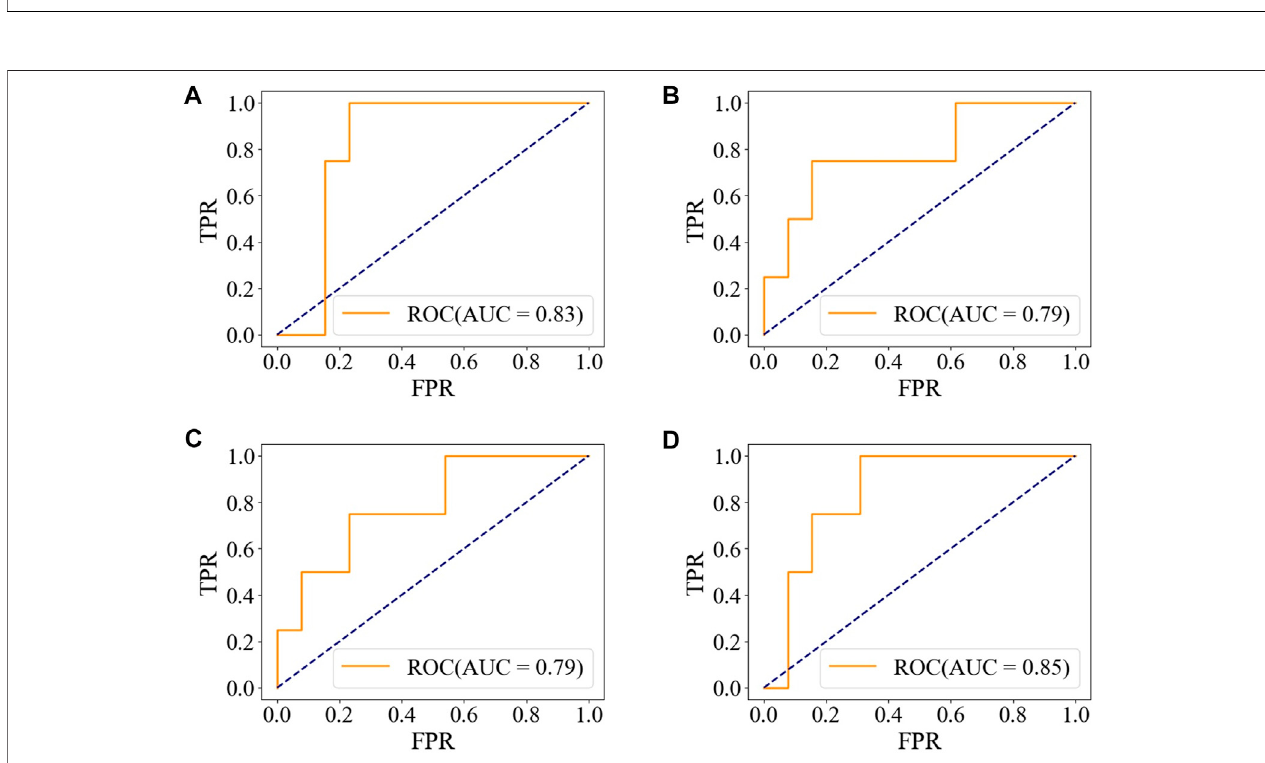
FIGURE 8 | ROC of the ensemble model and individual models on the test set. (A) XGBoost. (B) SVM. (C) LR. (D) Ensemble model with soft-voting of XGBoost, SVM, and LR.